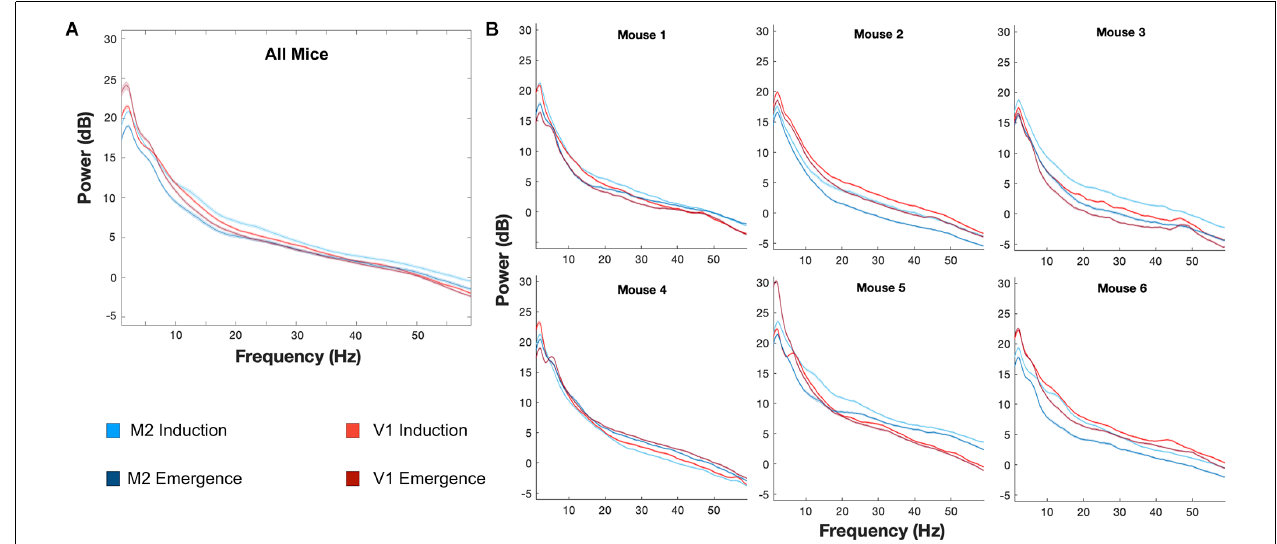
FIGURE 5 | Individual differences in induction and emergence evident in mean spectrum. Mean spectra across animals at M2 and V1 (A) demonstrate significant differences between induction and emergence. The mean spectra, however, mask the notable variation of spectra, and various differences between induction and emergence spectra, that occur in individual animals (B) . Lines represent the mean spectrum and shaded areas indicate the 99.979% confidence interval of the mean, corresponding to a p < 0.05 with Bonferroni correction for the multiple comparisons corresponding to each frequency. M2: Blue, V1: Red, Induction: Lighter Shade, Emergence: Darker Shade.